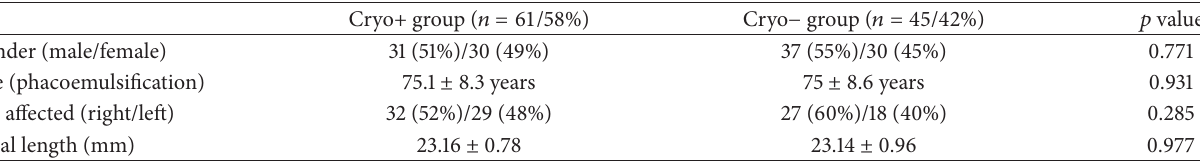
Table 1: Baseline characteristics of patients receiving prophylactic circumferential retinal cryopexy (cryo+) or not (cryo − ) after posterior capsule rupture during